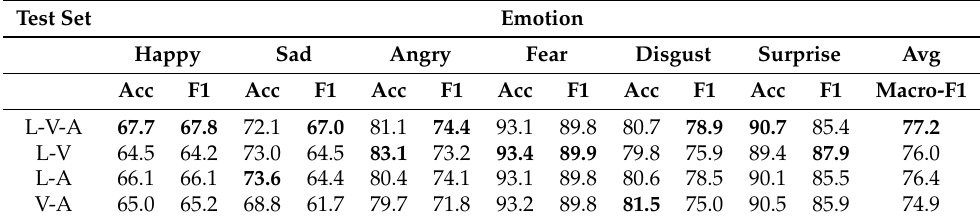
Table 4. Display of results of bimodal emotion classification. L: Language, V: Visual, A: Acoustic. Test